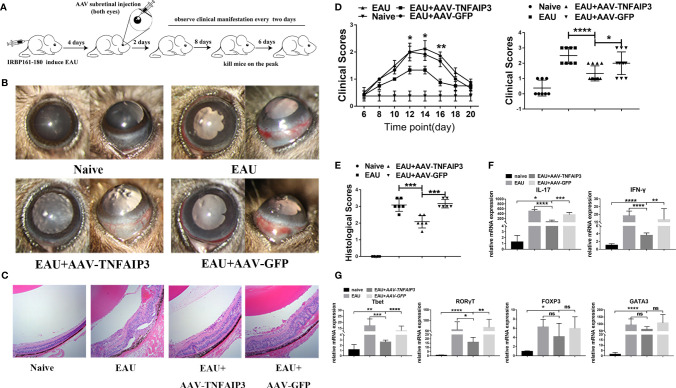
A20 overexpression in early onset suppressed the severity of EAU. (A) Both eyes were injected with AAV-TNFAIP3 or AAV-GFP, EAU was induced by IRBP161-180 immunization fourteen days later. (B) Representative slit-lamp images of EAU mice at the 14th day after immunization from the frontal and lateral view. (C) Representative histological image is shown of eyes harvested at the 14th day after immunization. (D) The clinical scores were measured every two days from day 6 after IRBP immunization. The clinical score at the peak of EAU peak (day 14) is shown in the right panel (n≥6 per group, p value was compared between AAV-TNFAIP3 group and AAV-GFP group). (E) Histological scores were assessed by hematoxylin and eosin (H&E) staining of paraffin-embedded sections. (F) Relative mRNA expression of Th1 and Th17 cytokines IFN-γ and IL-17 by RT-qPCR (n≥4 per group). (G) Relative mRNA expression of transcription factors T-bet, RORγT, GATA3, and FOXP3 in CD4+T cells by RT-qPCR (n≥4 per group). Scale bar = 50 μm. Data were shown as mean ± SD. One-way ANOVA was used, ns p>0.05, *p<0.05, **p<0.01, ***p<0.001, ****p<0.0001.